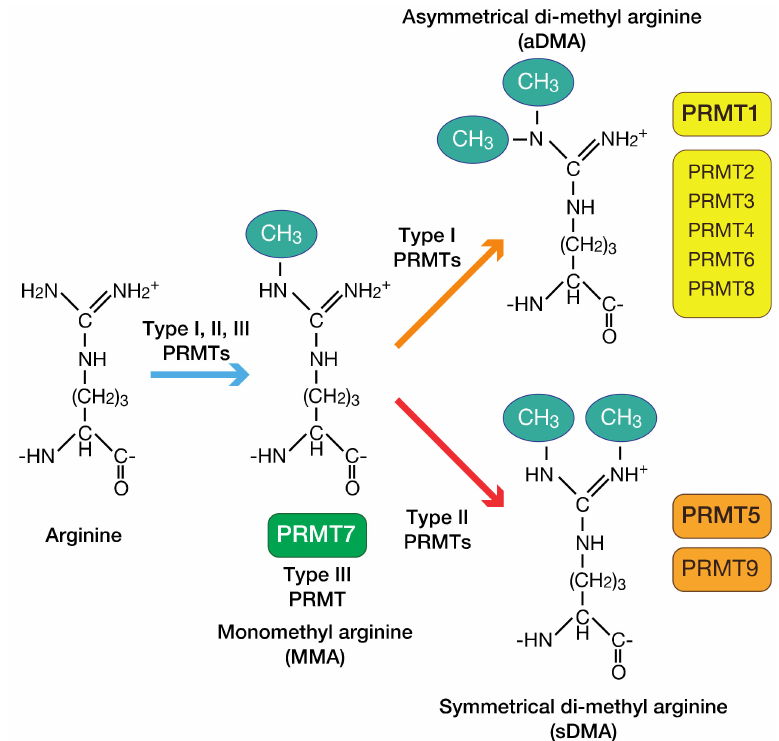
Figure 3. Protein arginine methylation. All of the protein arginine methyl transferase (PRMT) family of proteins catalyze monomethylated arginine. Type I PRMTs then catalyze asymmetrical methylated arginine, whereas type II PRMTs catalyze symmetrical methylated arginine. The type III PRMT catalyzes only monomethyl